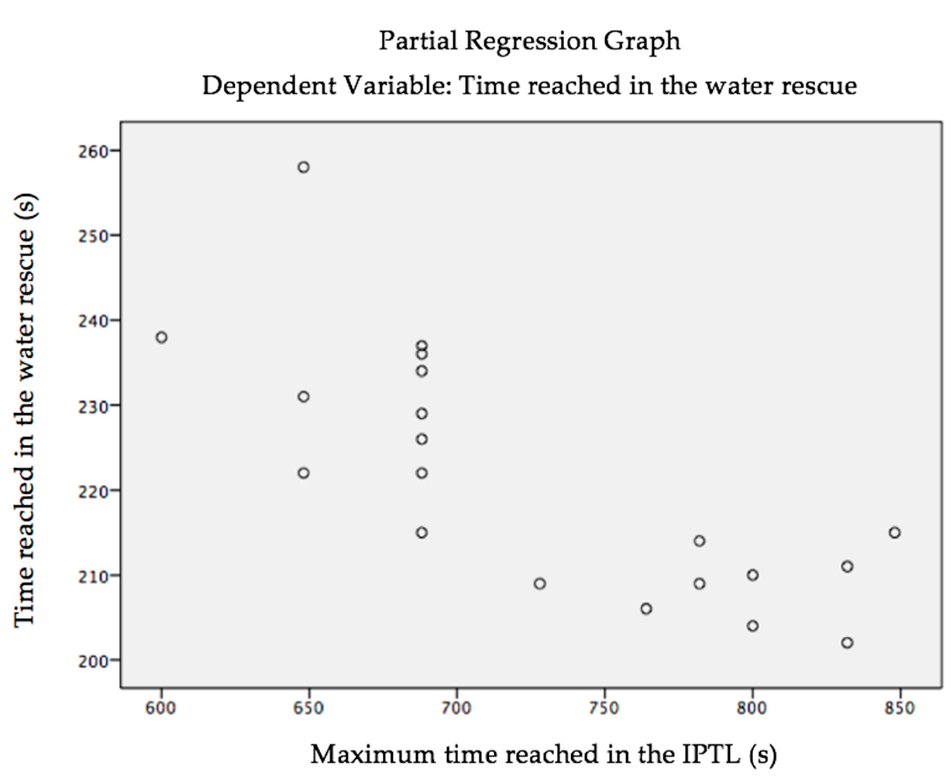
Figure 1. Partial regression between time spent in the rescue (TimeRescue) and time reached in the Incremental Test in Pool for Lifeguards (IPTL) (TimeIPTL).